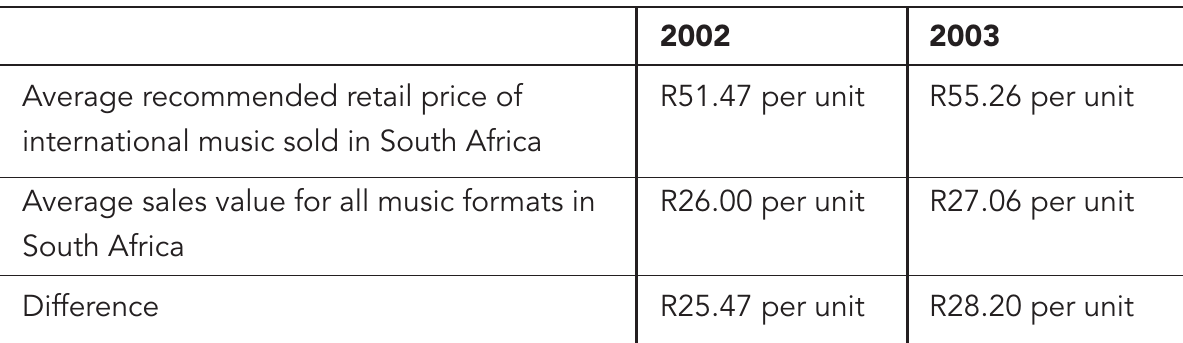
Table 3: Comparison of sales value per